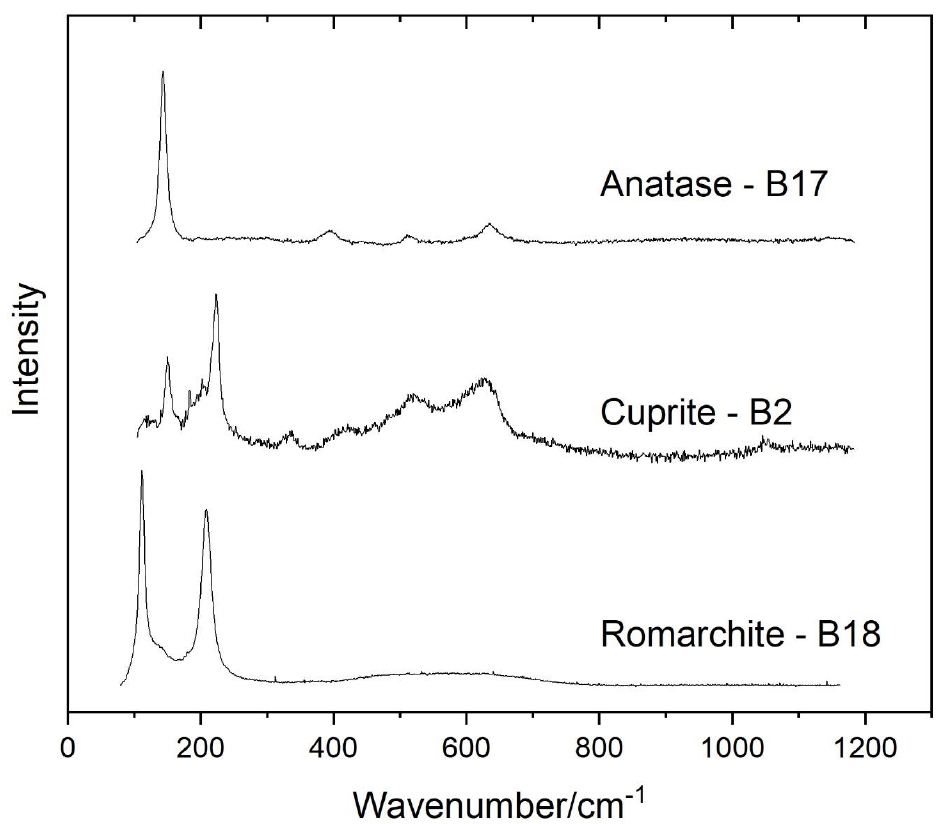
Figure 8. Raman spectra of different oxides found in the gilding material, and used for restorations.